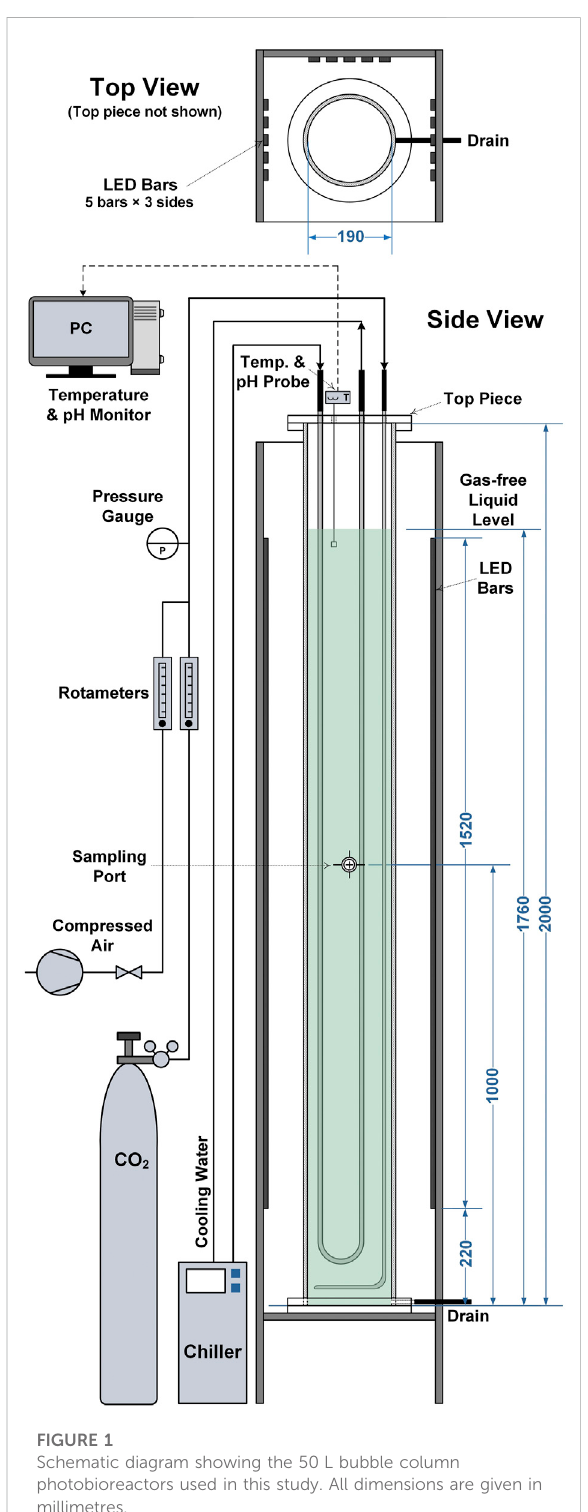
FIGURE 1 Schematic diagram showing the 50 L bubble column photobioreactors used in this study. All dimensions are given in